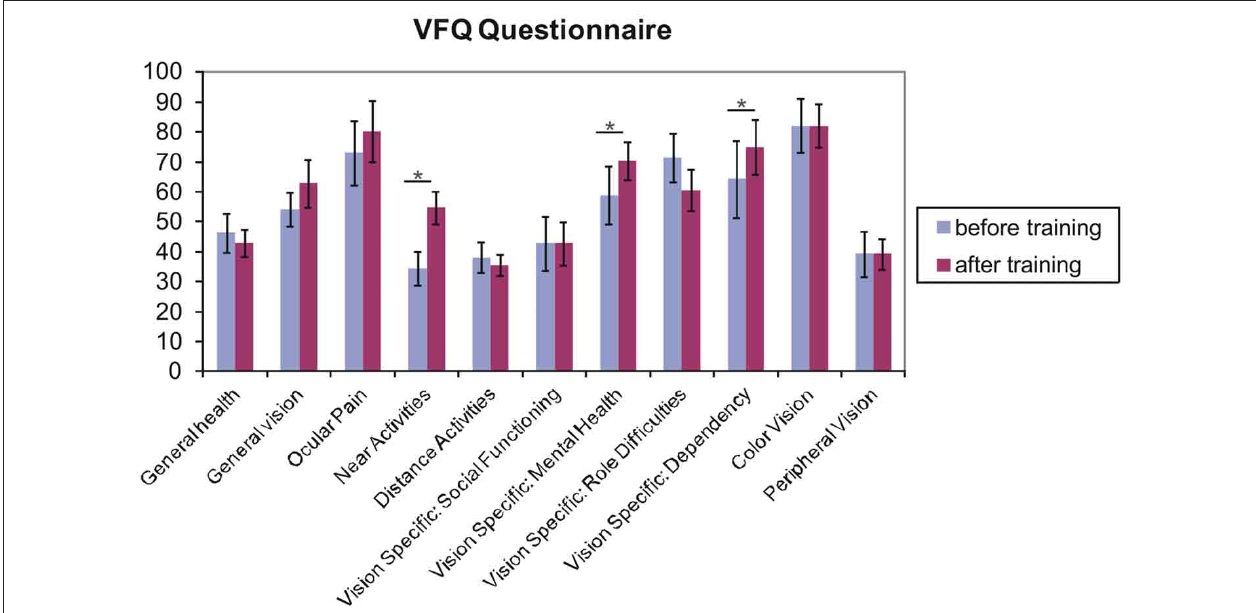
FIGURE 6 | Results from the Visual Functioning Questionnaire. One sided t -test revealed that fixation training significantly improved subjects’ judgments of their near visual activities, their vision-specific mental health (depressive